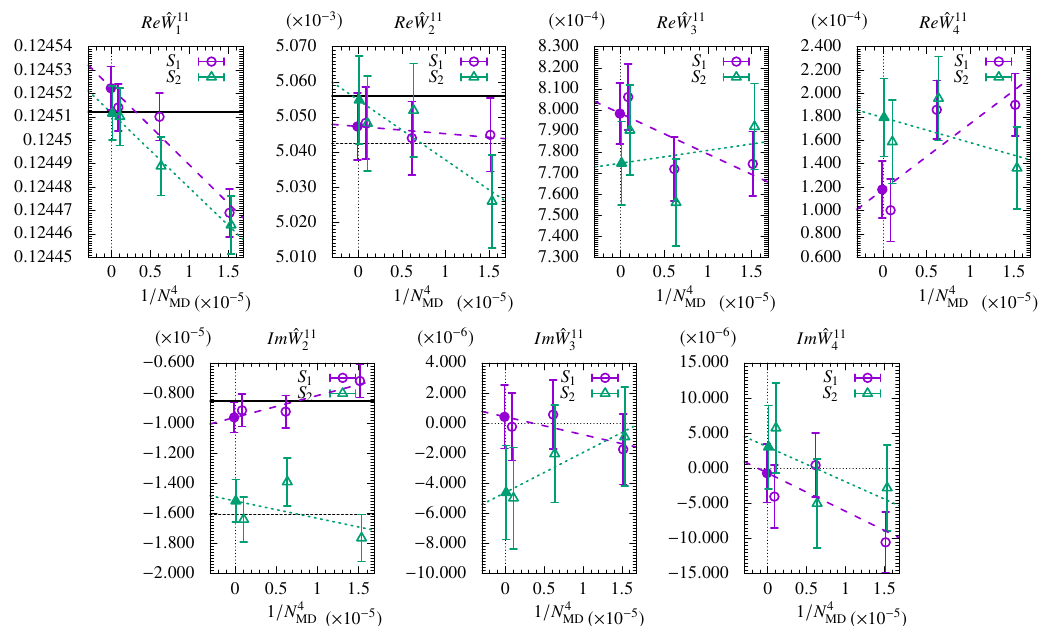
Figure 1. MD step size dependence and extrapolation for Re ^ W 11 ( N; k ) = (16 ; 1).